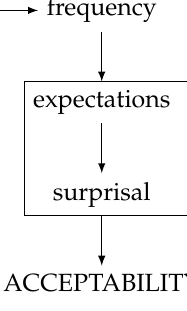
Figure 1. The logic of acceptability judgments for grammatical conditions.